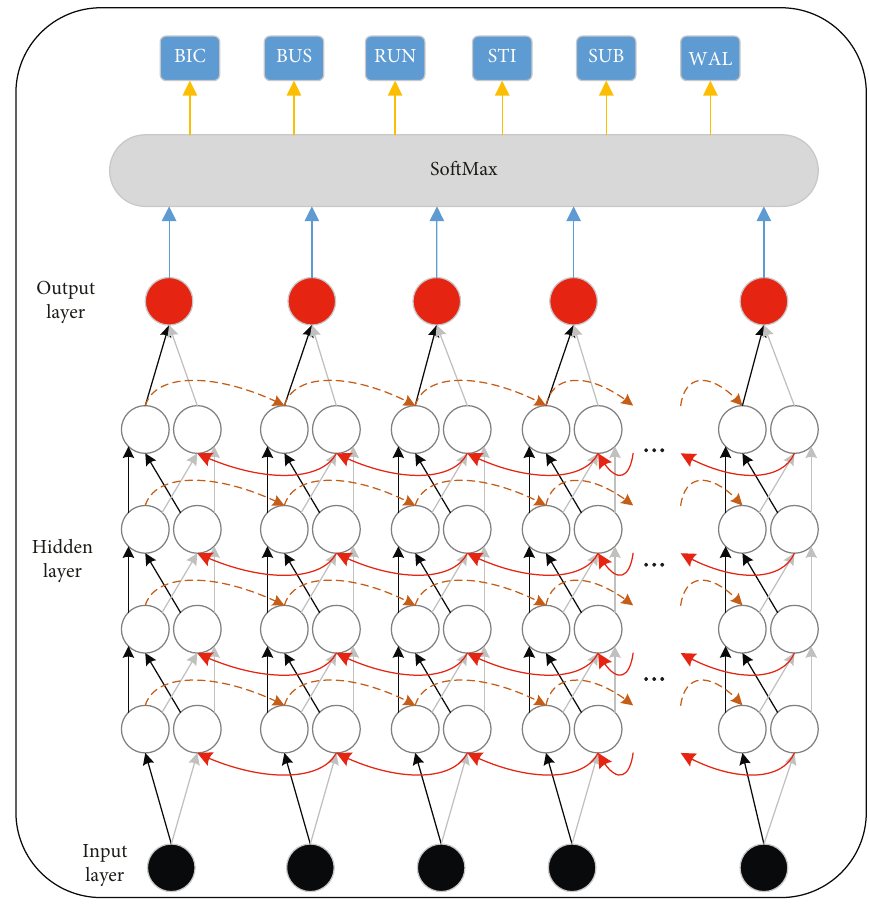
Figure 8: Structure of experimental neural